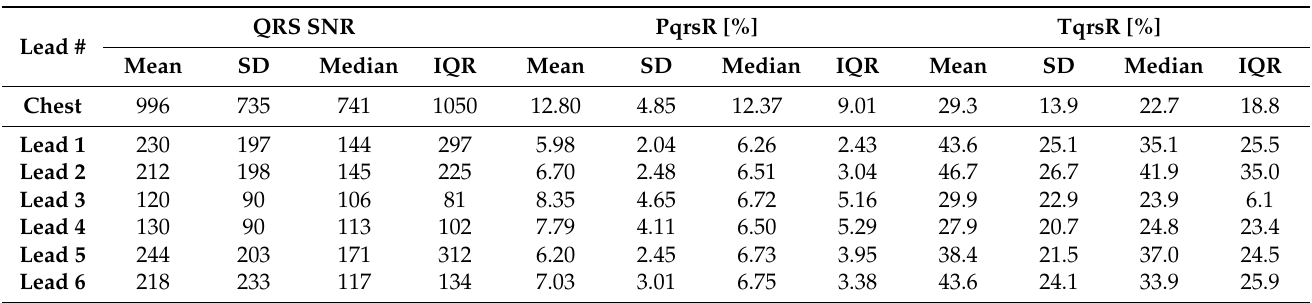
Table 3. Statistics summary of EDQ metrics: ECG event signal ratio metrics (QRS SNR, PqrsR%, TqrsR%), results summary on the SAECG of the six bipolar arm-leads and on the reference Chest- Lead, over the 18 subject cases, after outliers removal.